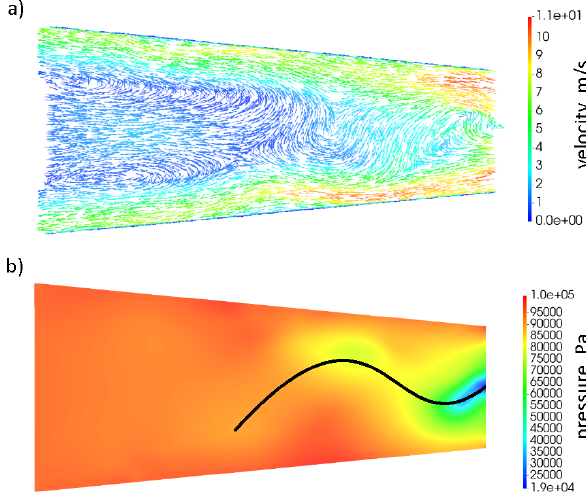
Figure 5: The distribution of the velocity (a) and pressure (b) in draft